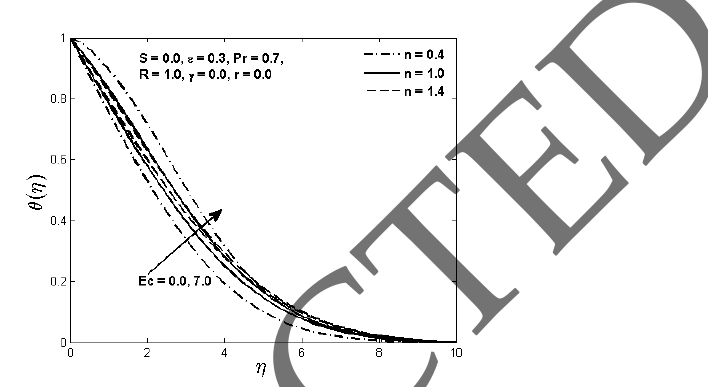
Figure 6. Temperature profiles for various values of Ec and n .